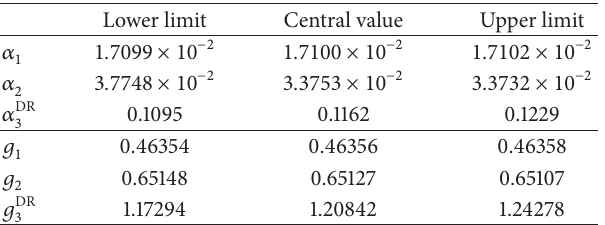
Table 2: Numerical values of gauge couplings at top quark mass scale 𝑚 𝑡 .